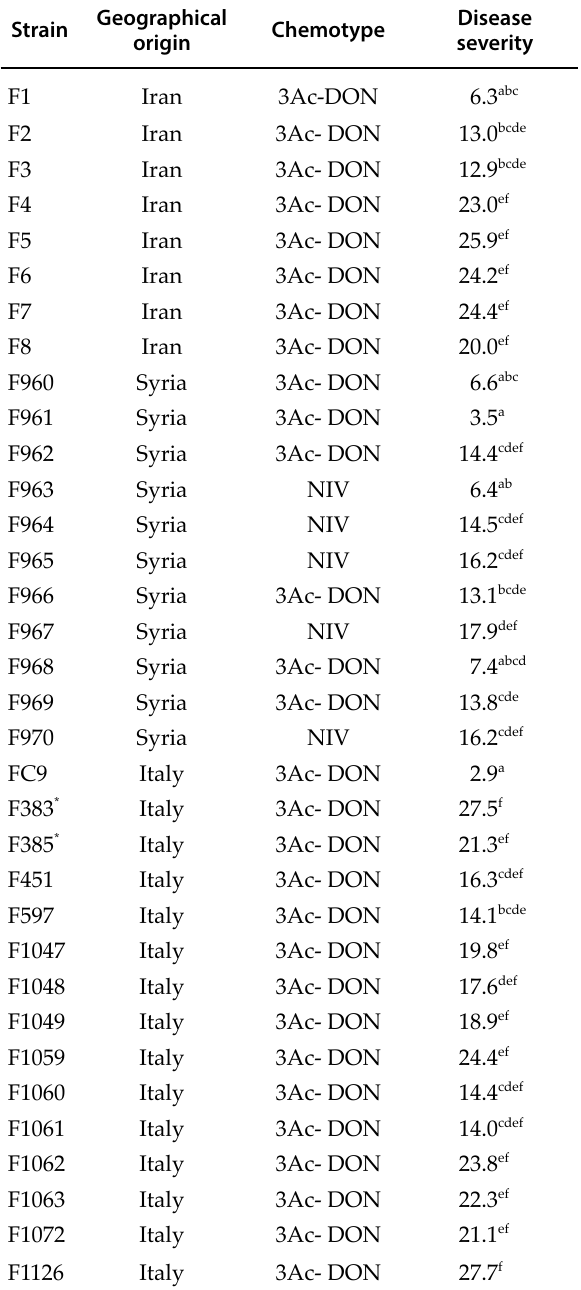
Table 2. Number, origins and chemotypes of Fusarium culmorum strains, and disease severity (DS; determined in a pathogenicity assay), in durum wheat cv. Normanno. Mean disease severities accompanied by the same letter are not significantly different ( P ≥